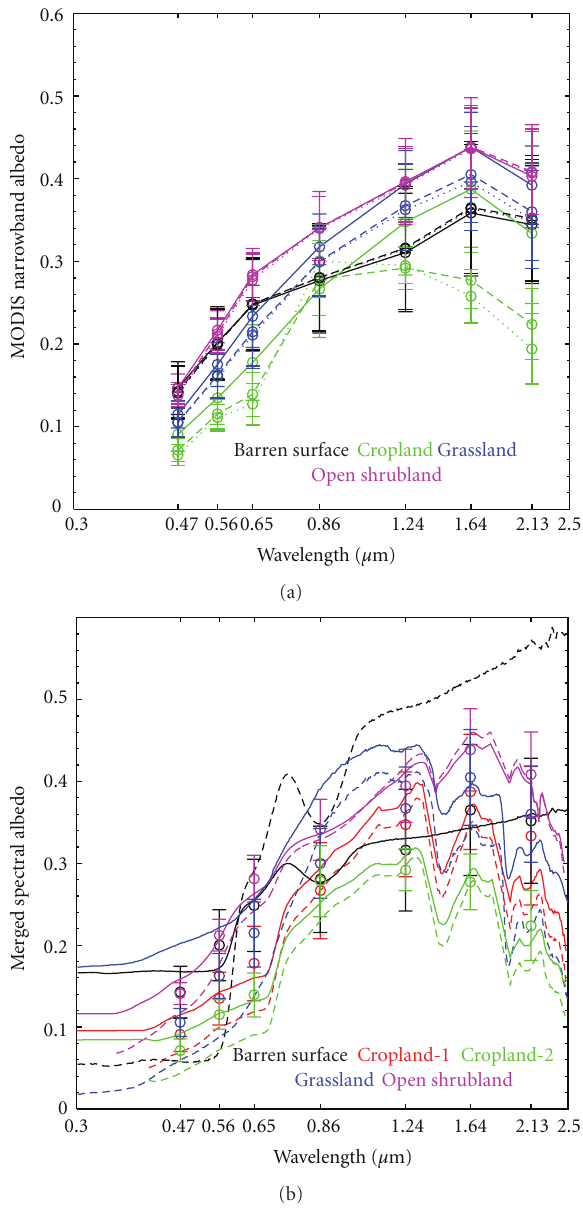
Figure 3: (a) Mean value (unfilled circles) and standard deviation (error bars) of MODIS narrowband albedo for di ff erent dryland ecosystems (barren surface, cropland, grassland, and open shrub- land). Data are averaged for the production periods of April 23 (solid curve), May 1 (dash curve), and May 9 (dotted curve) in 2001. (b) Reconstructed spectral surface albedo (solid curves) by merging MODIS albedo with the USGS spectroscopy dataset (dotted